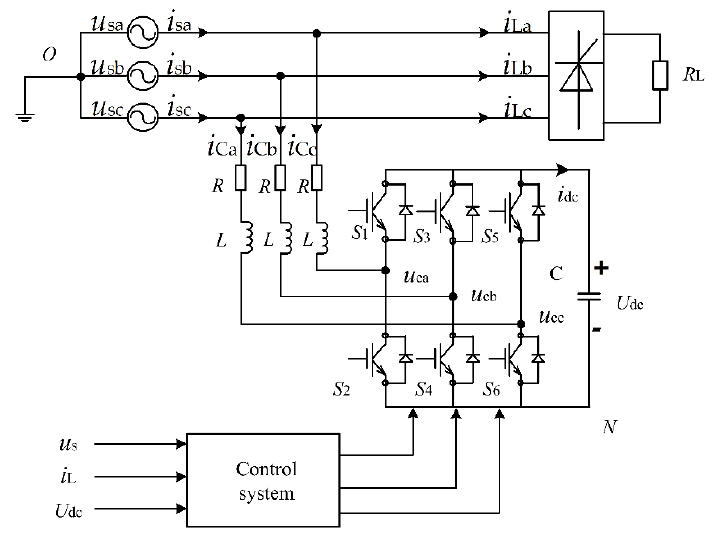
Figure 1. The diagram of SVG main circuit structure.